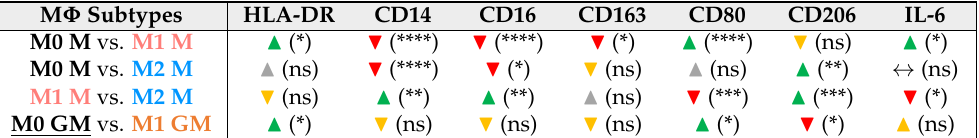
Table 1. Summary of the protein marker expressions used for phenotypic characterization of the M Φ subtypes generated in this study. The maturation of M Φ was performed using M-CSF (M) or GM-CSF (GM), while activation was performed with IFN- γ /LPS (M1), IL-4 (M2), or with no additive (M0). Data were analyzed with a one-way ANOVA, followed by Tukey’s multiple comparison tests: ns (not significant), p < 0.05 (*), p < 0.01 (**), p < 0.001 (***), p < 0.0001 (****). The comparisons shown refer to the latter M Φ subtype. Significant relative expression increases are indicated by the symbol “ (cid:78) ”, and decreases by the symbol “ (cid:72) ”. Nonsignificant increases or reductions are indicated by the symbols “ (cid:78) ” and “ (cid:72) ”, respectively, while changes in no particular direction are indicated by “ ↔